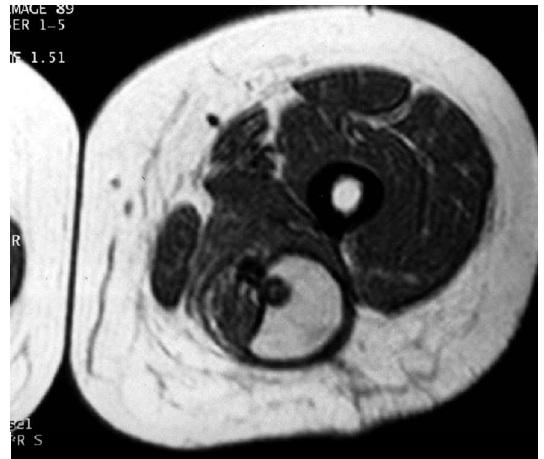
Fig. 1. Magnetic resonance scan of left thigh showing a seroma enveloping the sciatic